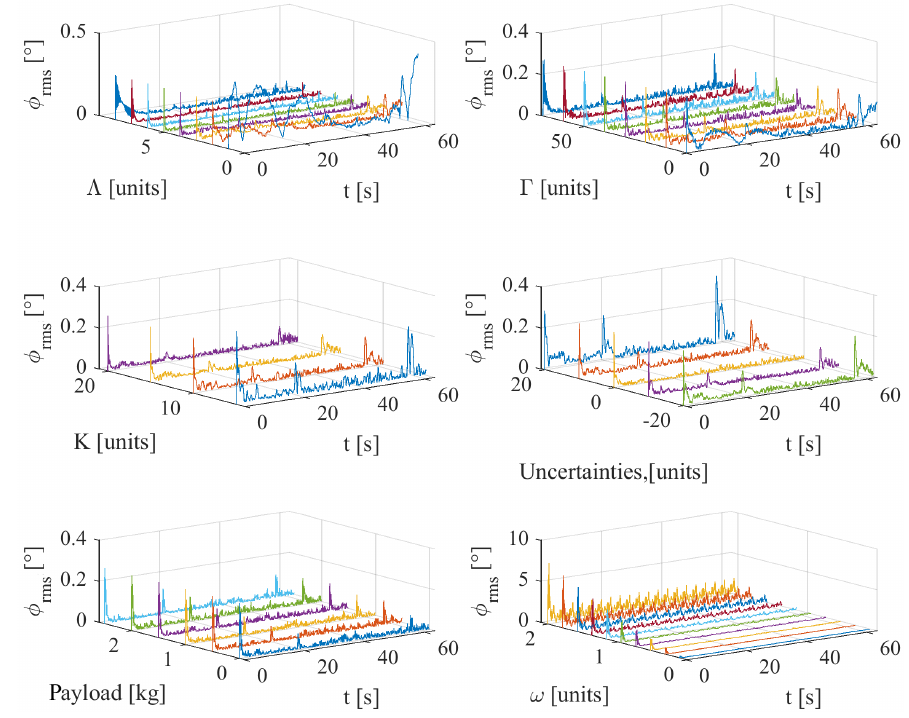
Figure 11. Sensitivity and robustness analysis results: Time trajectories of the norm of the end-effector orientation